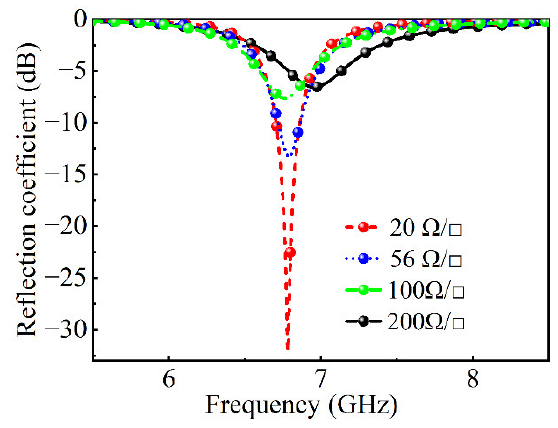
Figure 4. The reflection coefficient with the different square resistances of VO 2 .